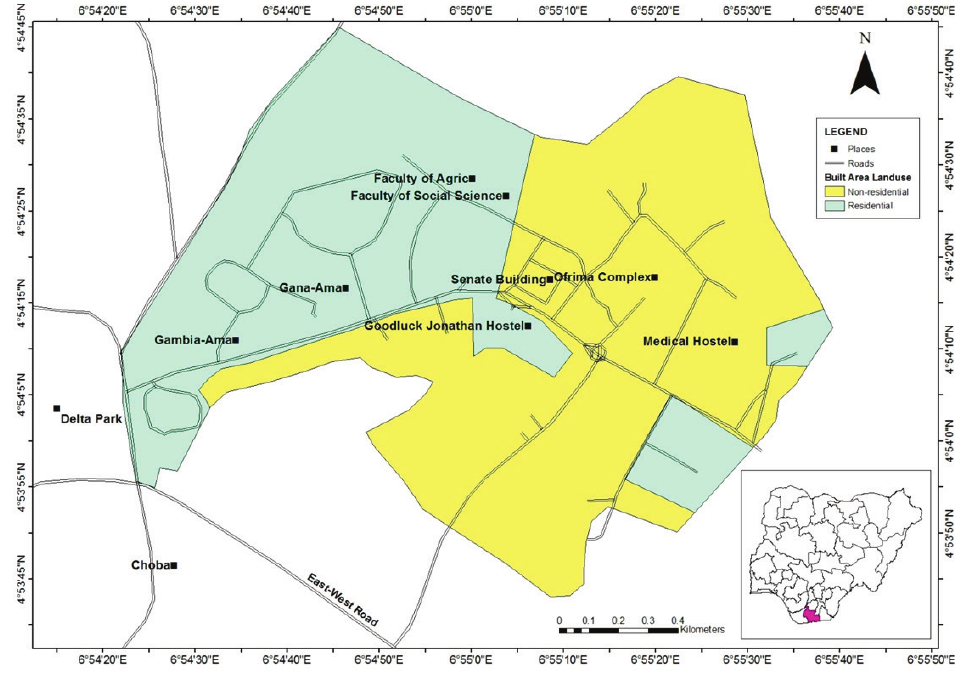
FIGURE 1. Map of University Park, University of Port